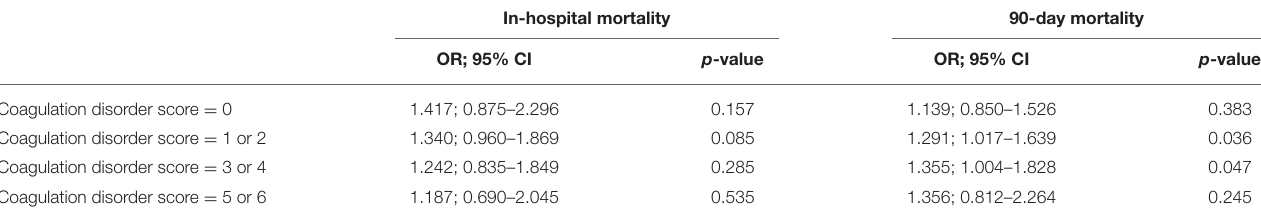
TABLE 5 | The interaction between AF and early coagulation disorder on